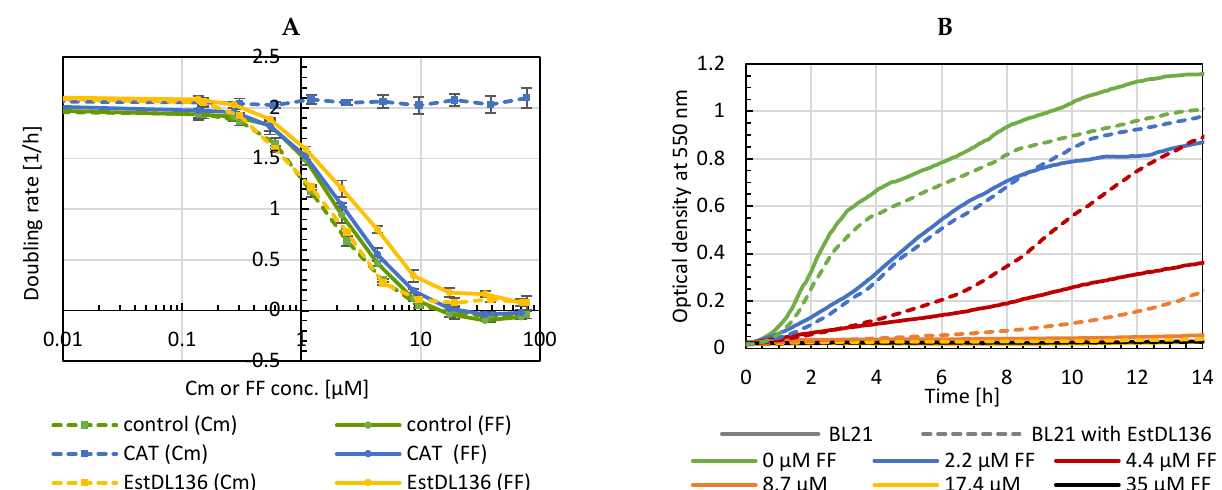
Figure 1. Growth assays in Cm or FF of E. coli expressing CAT or EstDL136. ( A ) Doubling rates were calculated from early logarithmic growth phase (control = BL21 without plasmid; n = 4). ( B ) Growth curves of BL21 without (straight line) or with hydrolase (dashed line) in media with different FF concentrations.